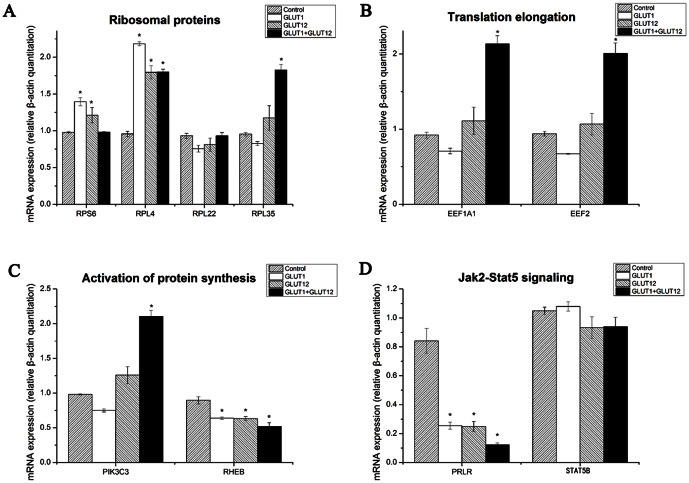
Change in expression of genes related to ribosomal proteins (A), translation elongation (B), activation of protein synthesis (C), and Jak2-Stat5 signaling (D).Data are expressed as means ± SE (n = 3). *P<0.05.